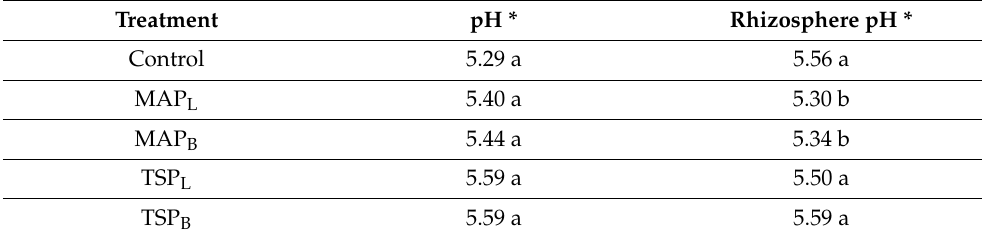
Table 1. The pH values to a Rhodic Hapludox under different P